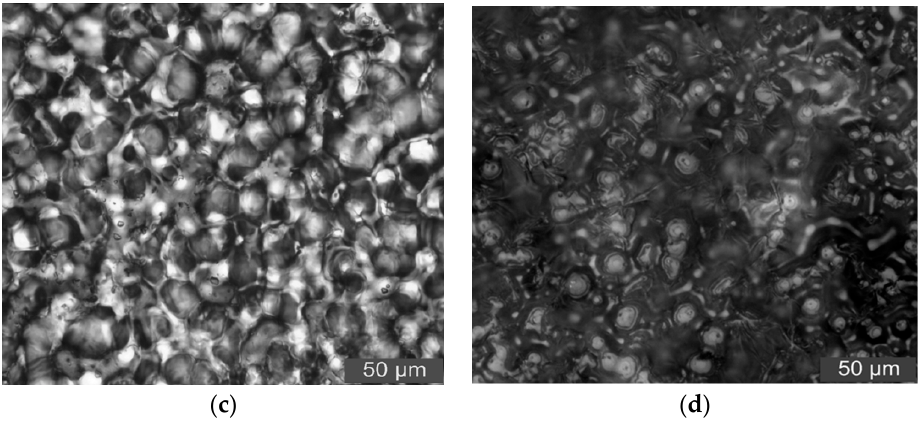
Figure 4. PLM pictures of Micro-Nano ZnO/LDPE composites. ( a ) LDPE; ( b ) N5; ( c ) M5; ( d ) N3M2.